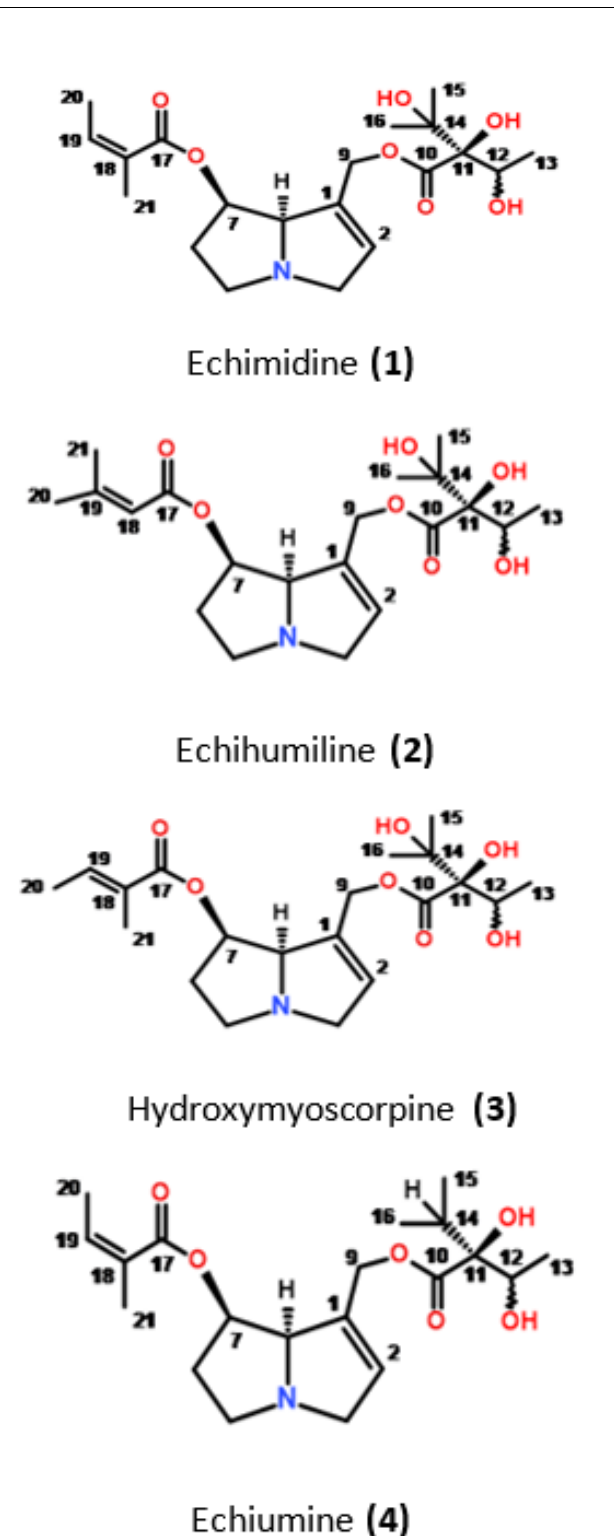
Figure 3. Structures of the investigated alkaloids (Stereochemistry at position C-12 not established).